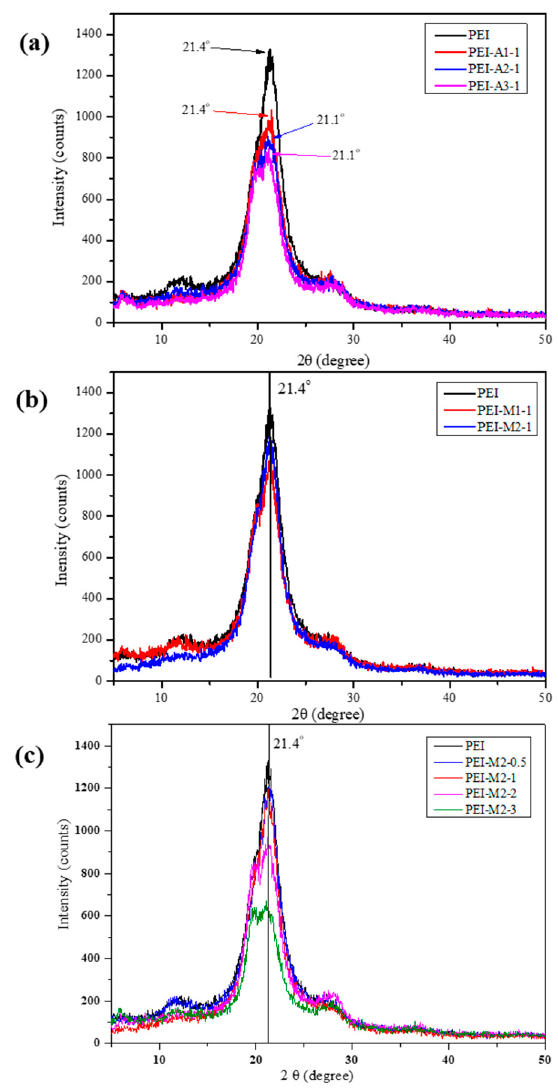
Figure 9. XRD curves of the PEI and its corresponding composite membranes containing the ( a ) hydrophobic MSPs (A1, A2, and A3), ( b ) hydrophobic M1 MSP, and ( c ) hydrophobic M2 MSP.